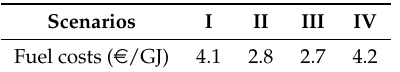
Table 19. Fuel production costs for onshore methanol production considering different synthesis gas compositions.